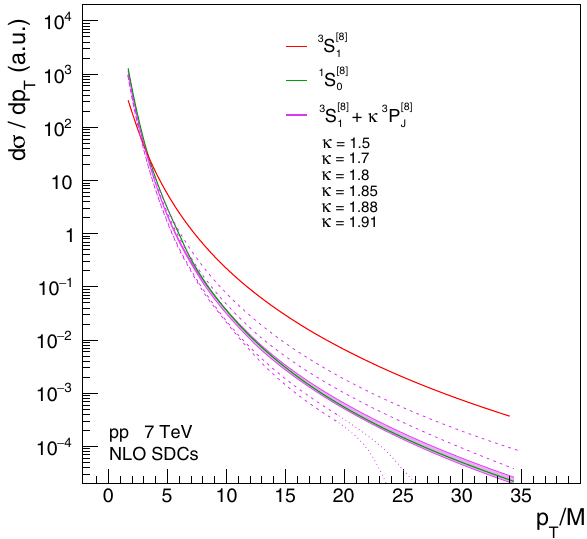
Fig. 2 The polarization parameter λ ϑ for the different components of / M : 1 S [ 8 ] (green), 3 S 0 1 quarkonium production in NLO NRQCD, as functions of p T + κ 3 P [ 8 ] combinations (magenta). The 1 S [ 8 ] J 1 (green), 3 S [ 8 ] (red), and several 3 S [ 8 ] 0 1 (magenta). The band represents the κ = 1 . 8–1.85 range, as in Fig. 1 SDC 0 entangle the three components. However, for p T / M (cid:2) 10, [ 1 ] [ 8 ] singlet term + κ 3 P [ 8 ] combination with κ in the 1.8–1.85 the 3 S 1 J 1